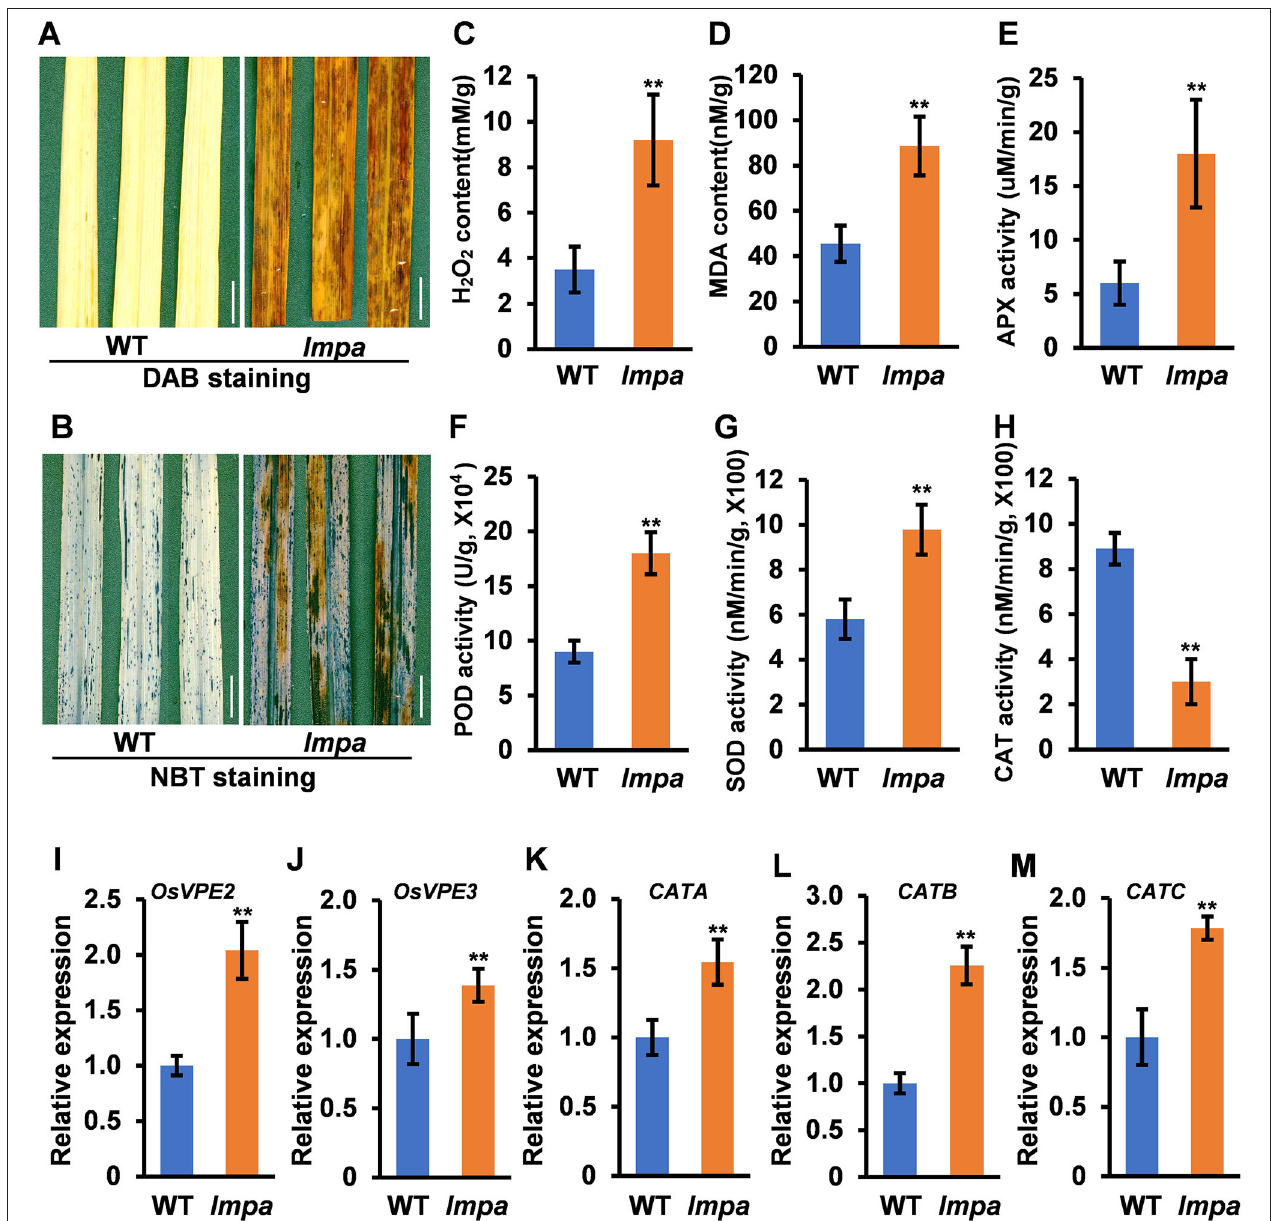
FIGURE 4 | Determination of ROS content in the wild type. (A) DAB straining in leaves of WT (left) and lmpa (right). (B) NBT staining in leaves of WT (left) and lmpa (right). (C–H) Measurement of H 2 O 2 content (C) , MDA content (D) , APX activity (E) , POD activity (F) , SOD activity (G) , and CAT activity (H) in leaves. (I–M) Expression levels of OsVPE2 (I) , OsVPE3 (J) , CATA (K) , CATB (L) , and CATC (M) in leaves. Error bars represent standard deviation (SD) ( n = 3); **Significant difference at p < 0.01 compared with the WT by Student’s t -test. Bars = 1cm in (A,B) .